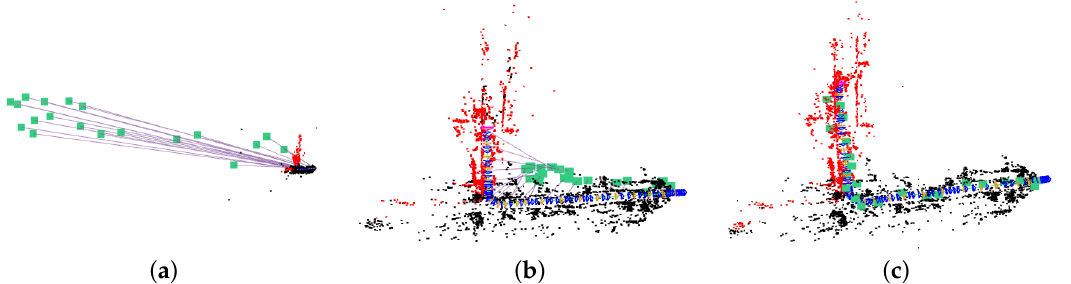
Figure 6. Initialization of Global Navigation Satellite System–visual-ORB–simultaneous localization and mapping (GVORB): ( a ) before initialization; ( b ) after scale initialization; ( c ) after pose initialization. The green square is the location measured by the GNSS receiver, and the blue trajectory comes from visual-SLAM. The purple lines are the connections between GNSS receivers and visual correspondences. The black and red points are the map points (MPs) (the red points are the MPs in the local optimization window).